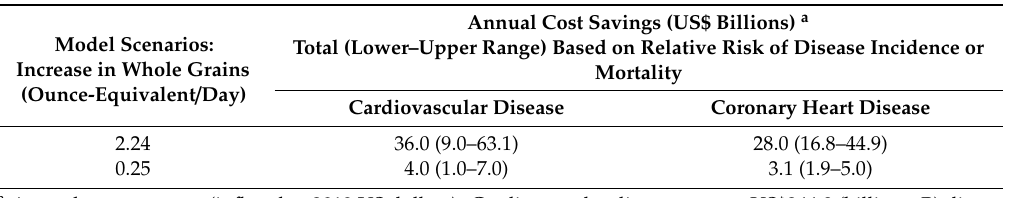
Table 3. Sensitivity analysis: Net direct medical and indirect cost savings associated with increased consumption of whole grains among adults in the